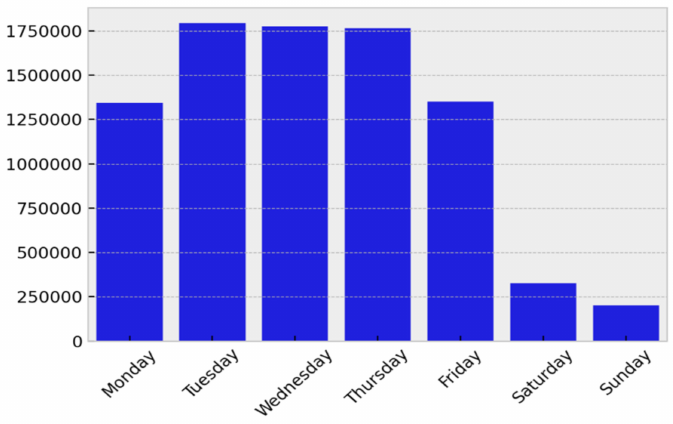
Figure 5. Amount of Reuters news by